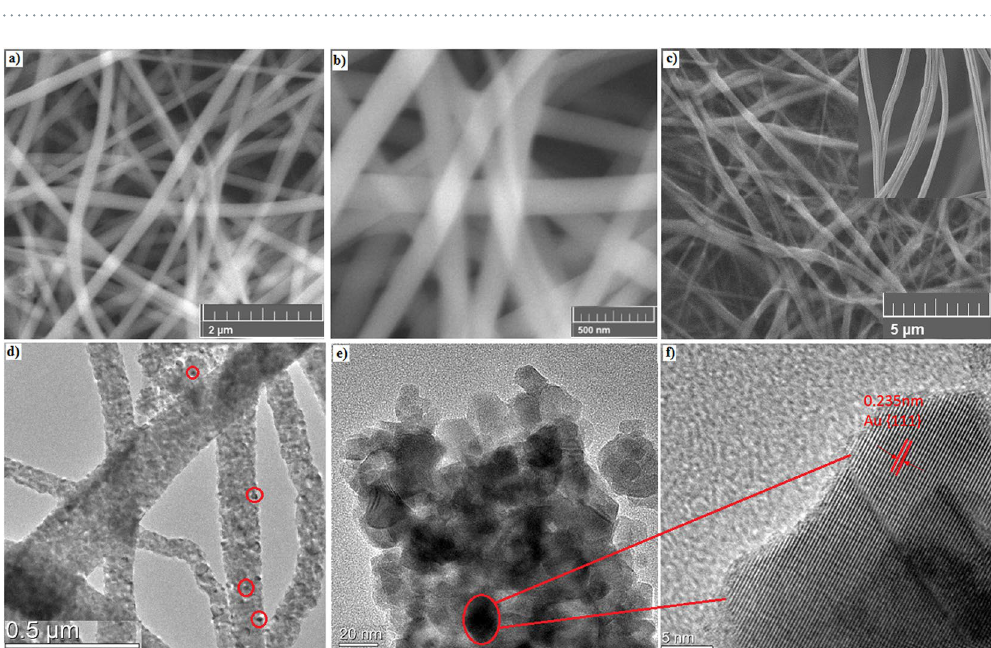
Figure 2. ( a , b ) SEM images of pure TiO 2 with different magnifications; ( c ) SEM images of the sample Au(10)/ TiO 2 , inset of ( c ) shows higher magnification; ( d , e ) TEM images of the sample Au(10)/TiO 2 with different magnifications; ( f ) HRTEM image of the sample Au(10)/TiO 2